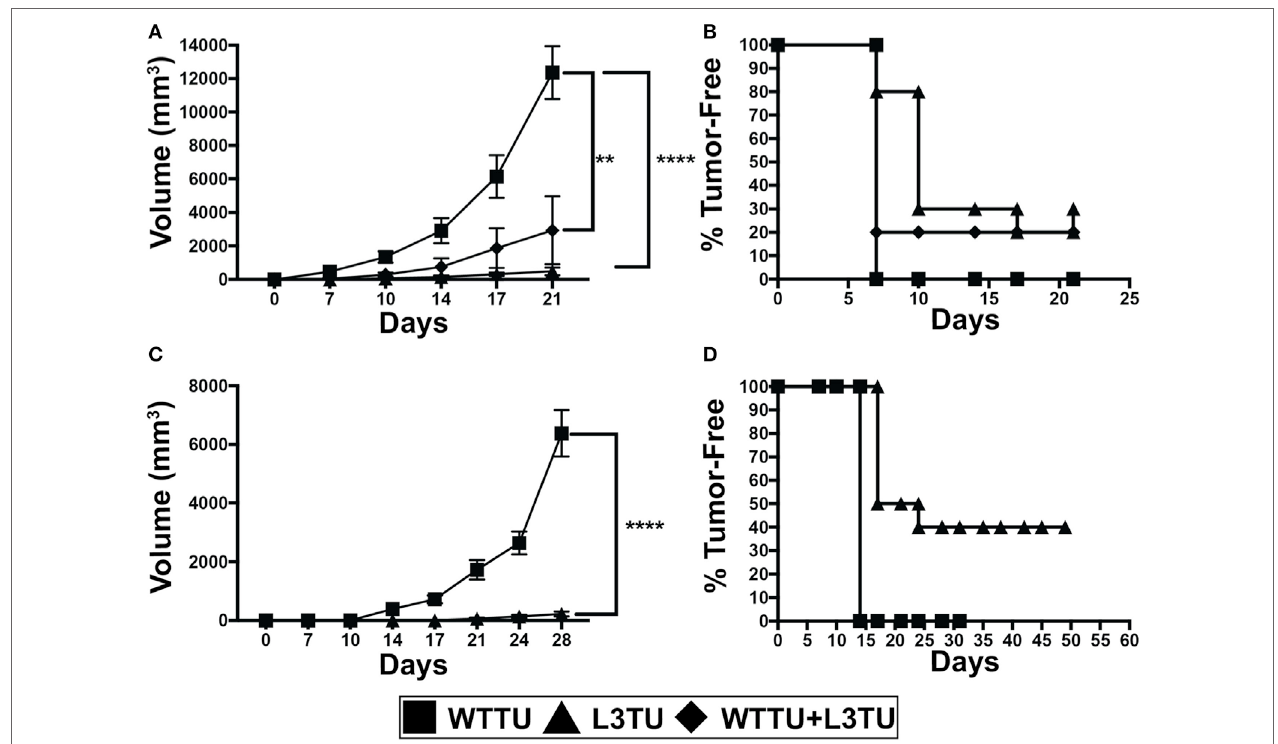
FigUre 1 | Autologous or recombinant CCL3 slows tumor growth and promotes tumor rejection. (a) Tumor growth kinetics of 1 × 10 6 tumor cells injected s.c. of WTTU ( n = 10), L3TU ( n = 10), or WTTU + L3TU mixed at a ratio of 1:1 ( n = 5). Experiments were repeated 3 times. (B) Kaplan–Meier graph showing overall tumor incidence of A. (c) Tumor growth kinetics of WTTU ( n = 10) and L3TU ( n = 10) after s.c. injections of 5 × 10 5 tumor cells. (D) Kaplan–Meier graph showing overall tumor incidence of C. Not significant (ns), p > 0.05; * p = 0.01 to 0.05; ** p = 0.001 to 0.01; *** p = 0.0001 to 0.001; **** p <